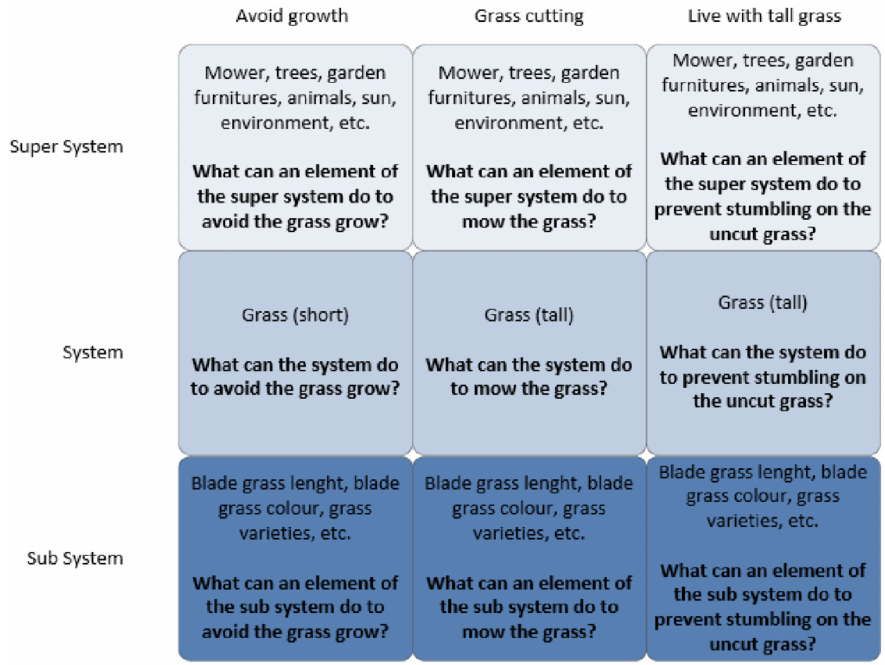
Figure A2. SO obtained with the proposed approach, for the example considered in Section